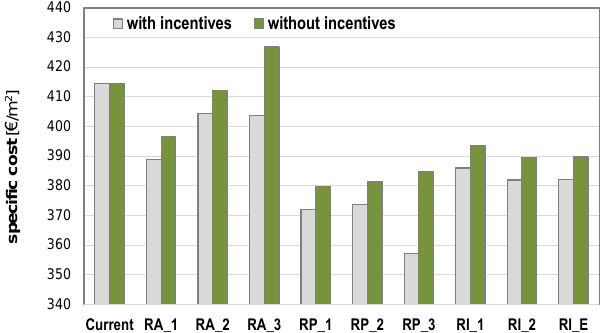
Figure 9. C g for unit heated surface with and without incentives.